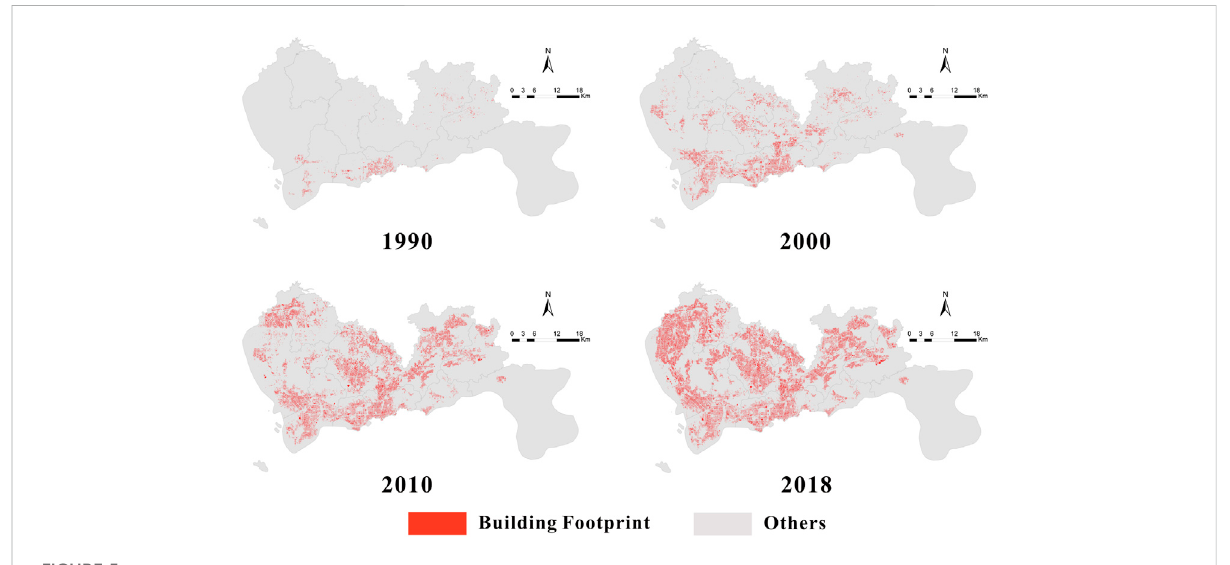
FIGURE 5 Building 2-D expansion in Shenzhen from 1990 to 2018.